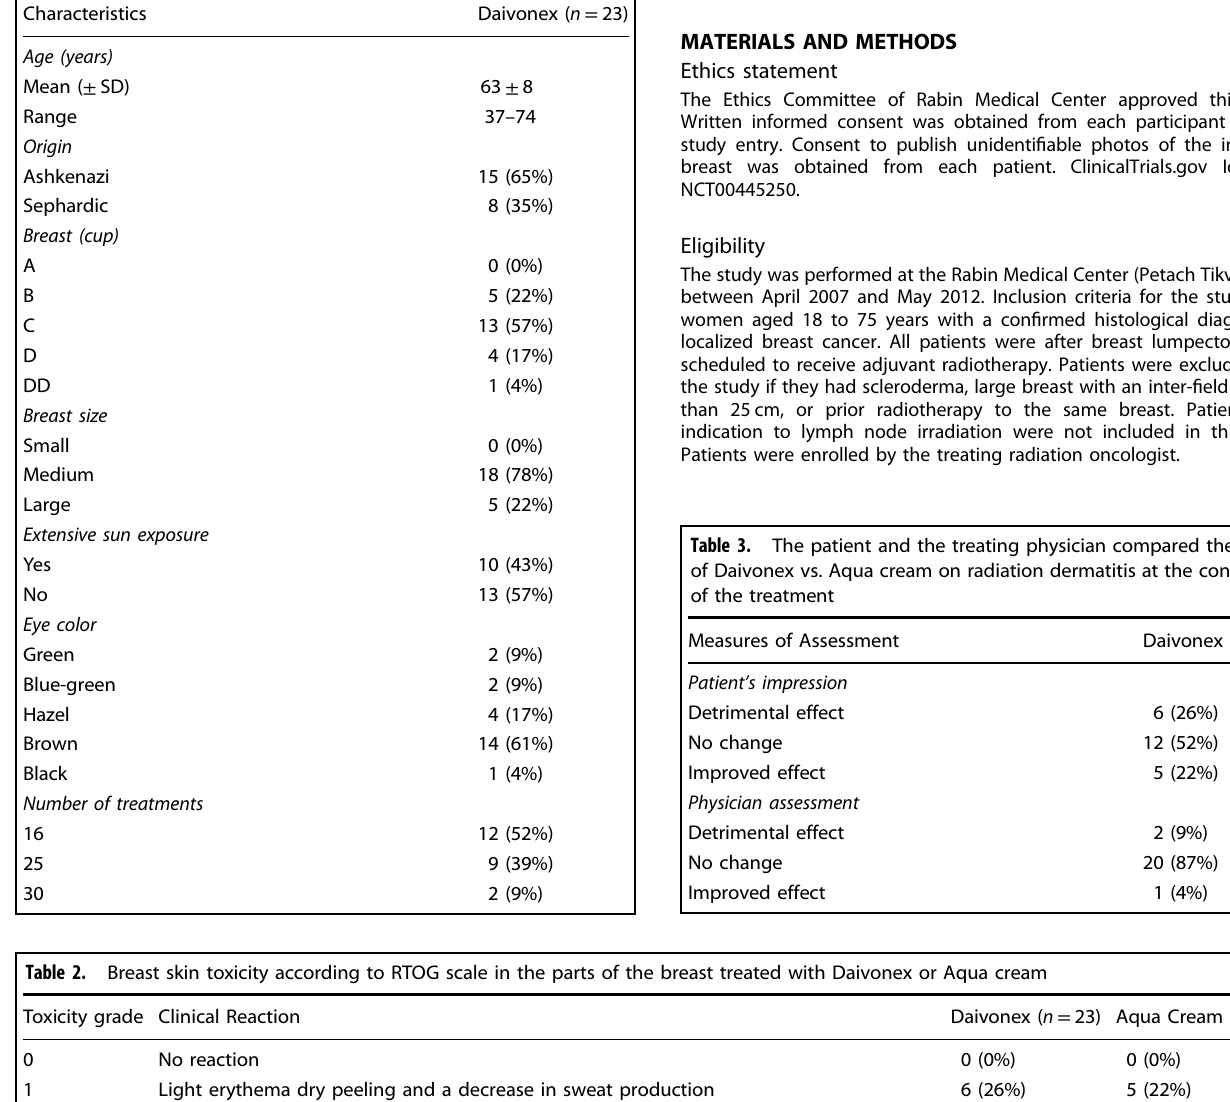
Table 1. Patient ’ s characteristics Characteristics